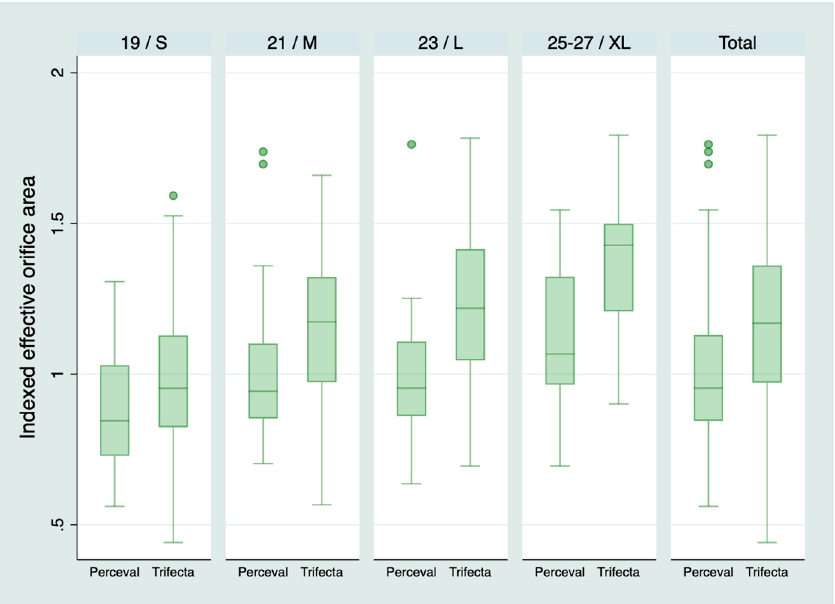
Figure 2. Indexed effective orifice area according to the type of prosthesis and size. Both types of prosthesis are presented together for visual inspection. However, size S of the Perceval is for an aortic annulus of 19–21 mm. Size M: 21–23 mm. Size L: 23–25 mm. Size XL: 25–27 mm [6]. Therefore, the size of a Perceval does not match the size of any Trifecta.